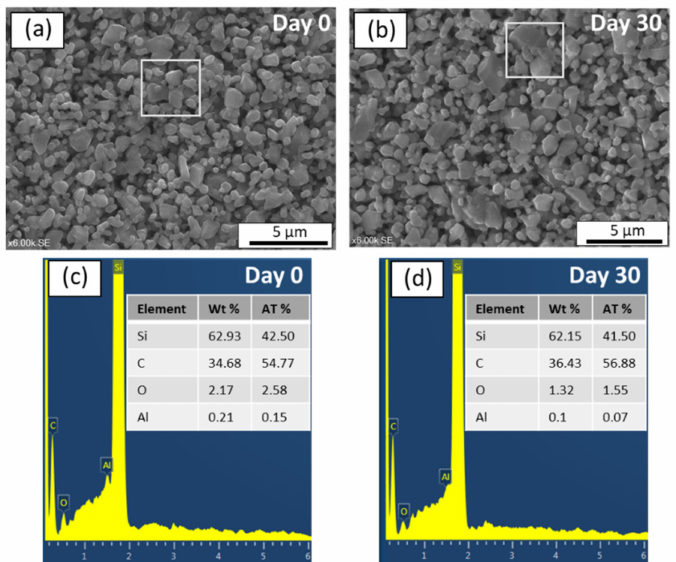
Figure 8. ( a , b ) SEM images of SiC membrane before and after alkali corrosion, respectively and ( c , d ) Chemical composition of SiC membrane layer before and after alkali corrosion,